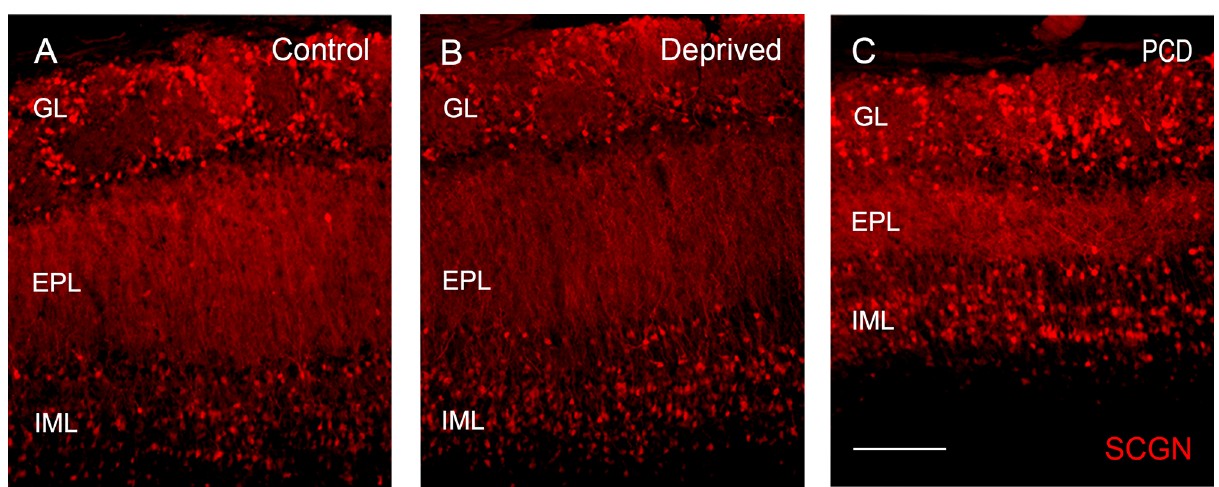
Figure 2. SCGN expression in control ( A ), deprived ( B ) and PCD ( C ) mice. SCGN-positive cells are mainly found in the glomerular (GL) and inframitral layers (IML); in addition, some isolated cells appear in the external plexiform layer (EPL). Note the reduction in the volume of the EPL in PCD animals. Scale bar equals 100